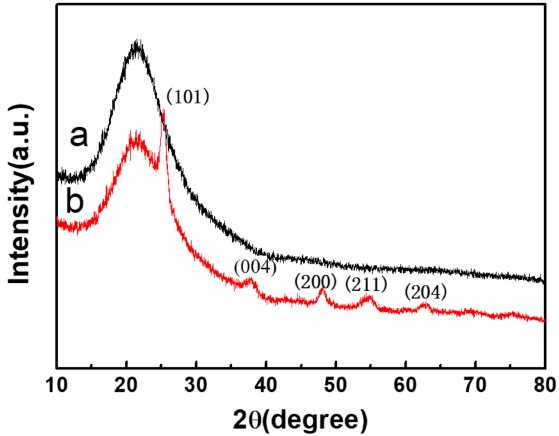
Figure 5. XRD patterns of SiO 2 and TiO 2 -SiO 2 .